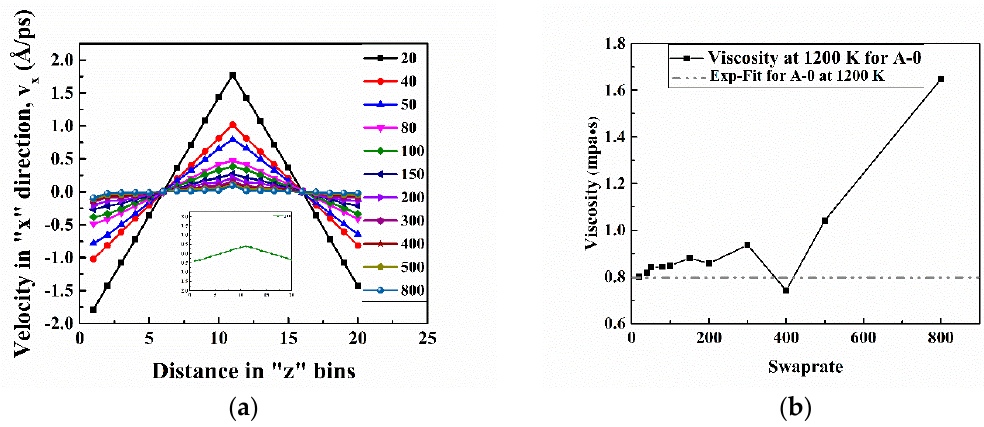
Figure 9. The swap rate influence on the A-0 at 1200 K. ( a ) Velocity profile of different swap rates. ( b ) The corresponding viscosities (Exp-fit data was obtained from [37].) Appl. Sci. 2018 , 8 , x FOR PEER REVIEW